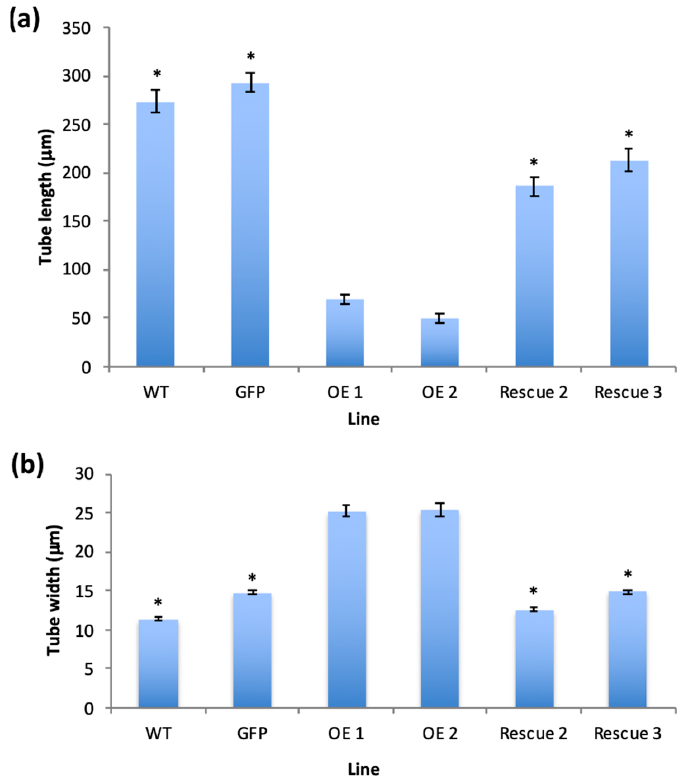
Figure 4. ( a ) Average pollen tube length ( µ m) and ( b ) average pollen tube width of the transgenic lines (as indicated) after 4 h of incubation at 28–30 °C. Plant lines shown: WT (wild type), GFP (transformant expressing GFP alone), OE1 and OE2 (transgenic lines expressing PiCDPK1-GFP alone), Rescue 2 and Rescue 3 (transgenic lines expressing PiCDPK1-GFP and PiRhoGDI1). Data are presented as means ± SE collected from >100 pollen tubes of each line, asterisks indicate significant differences between the samples labelled and the OE lines (Student’s t -test, p < 0.001).